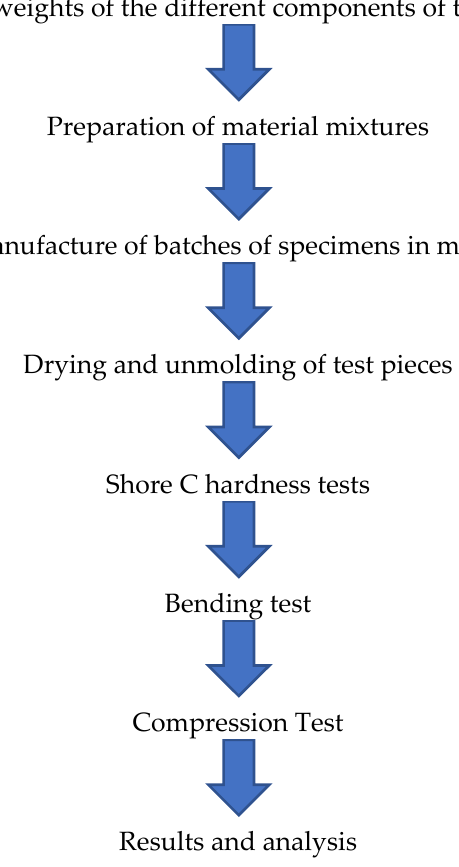
Figure 1. Flowchart of the experimentation methodology. (Source: the author.)